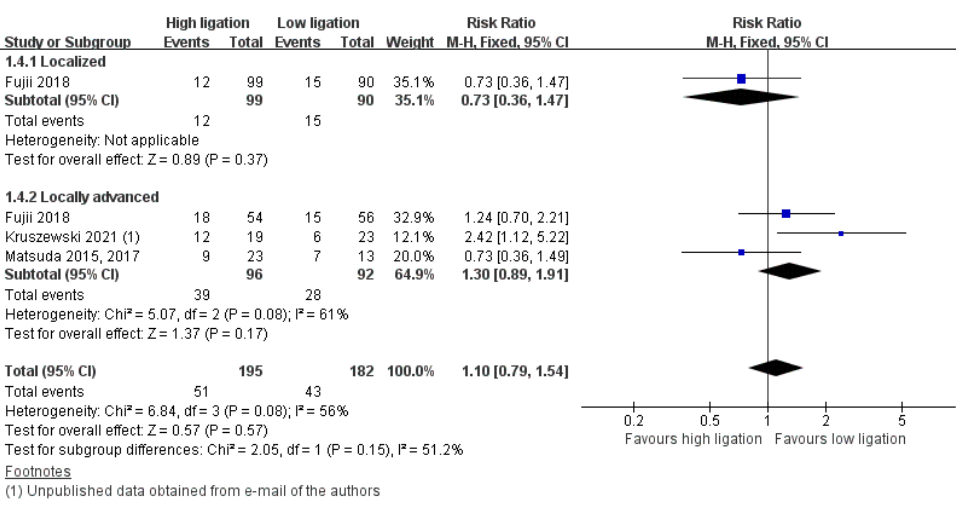
Figure 8. Forest plot of the subgroup analysis for 5-year disease recurrence .